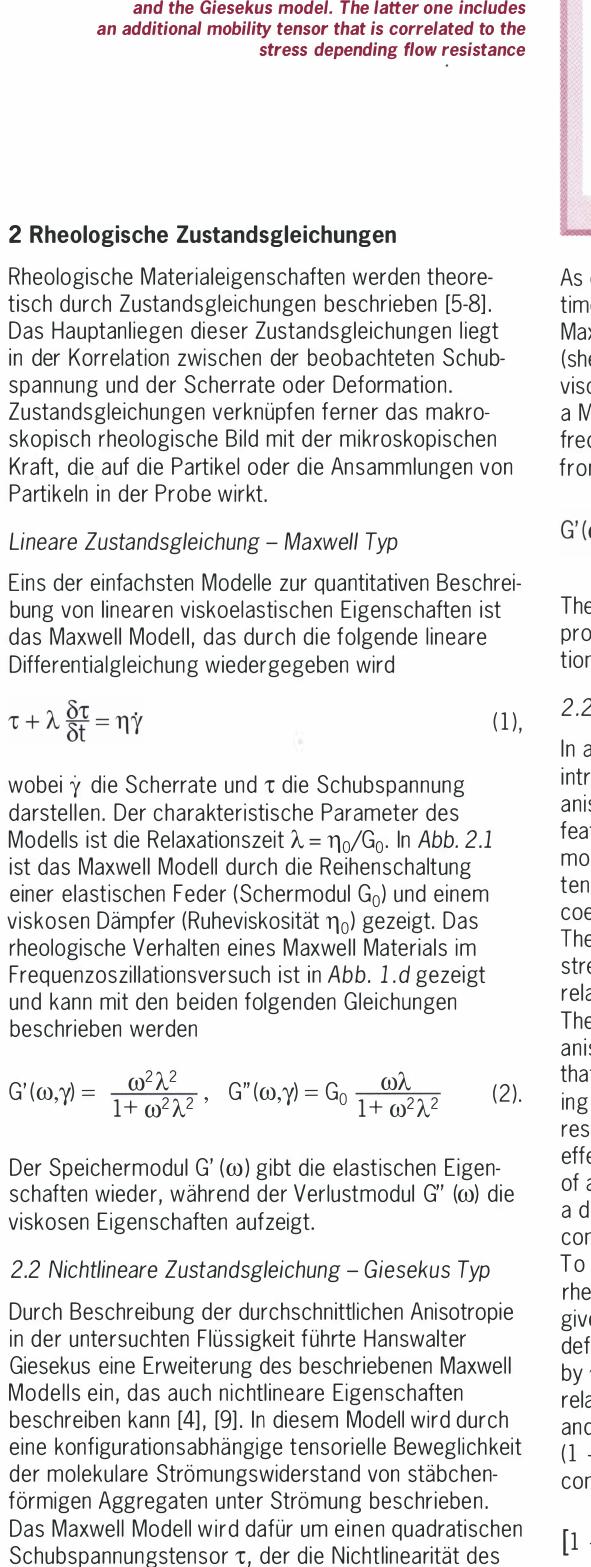
Fig. 2: chematica/ly drawing of the Maxwell model and the Giesekus model. The latter one includes an additional mobility tensor that is correlated to the stress depending flow